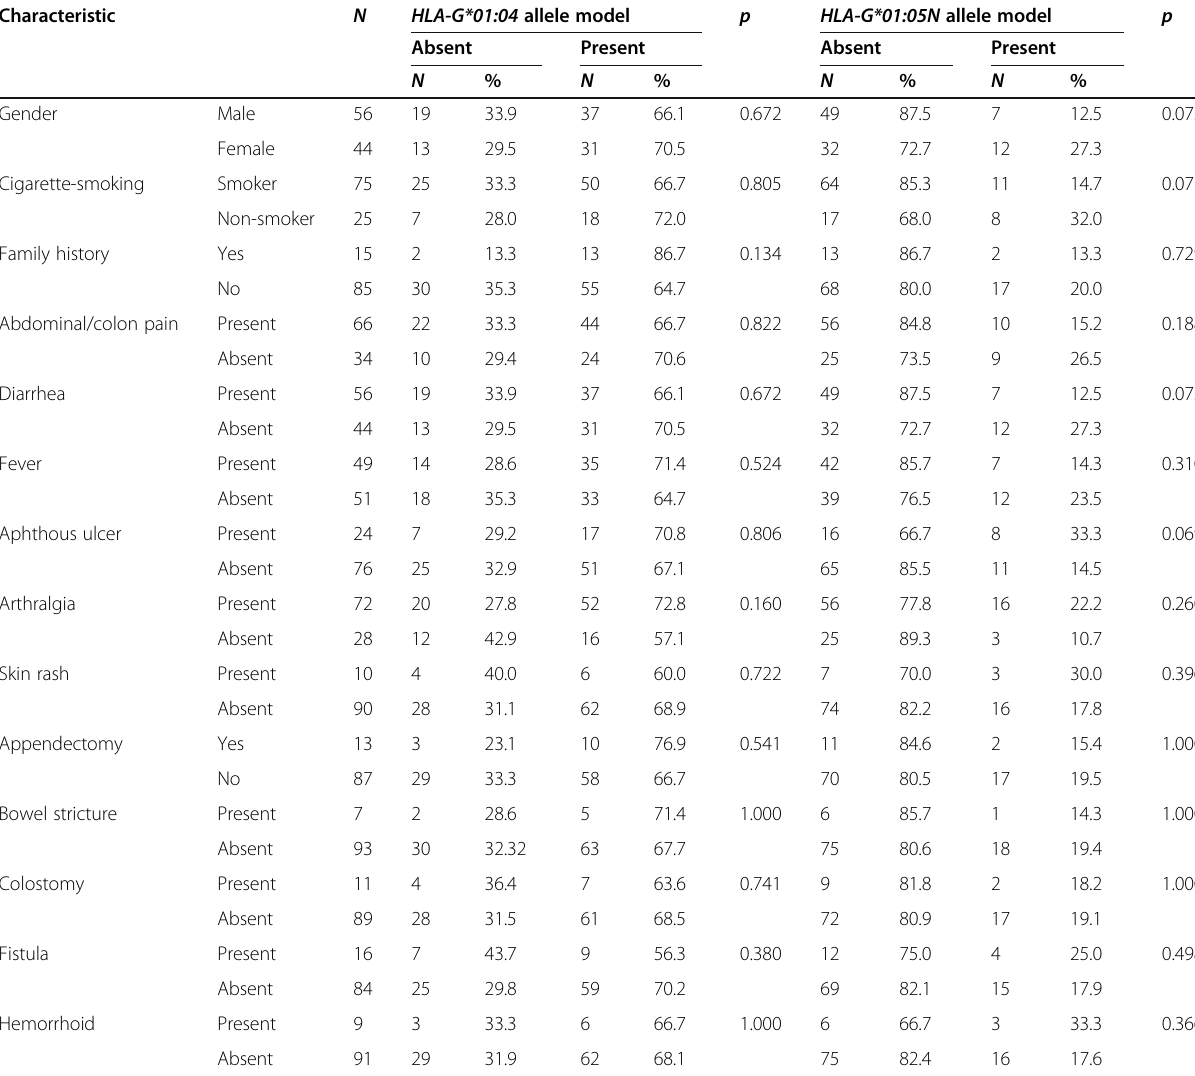
Table 5 HLA-G*01:04 and HLA-G*01:05N frequencies in inflammatory bowel disease patients classified according to demographic and clinical characteristics